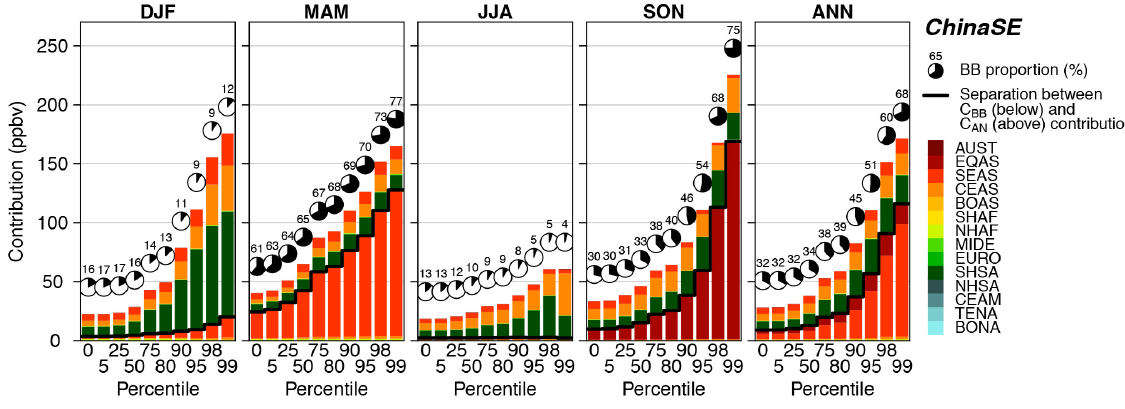
Figure 20. Same as Fig. 16 for the ChinaSE cluster.